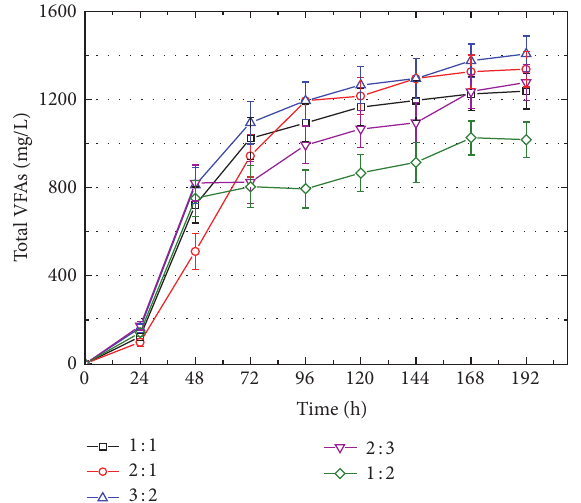
Figure1:PerformancesofVFAsproductionfromcodigestionofFW and SS at different ratios.